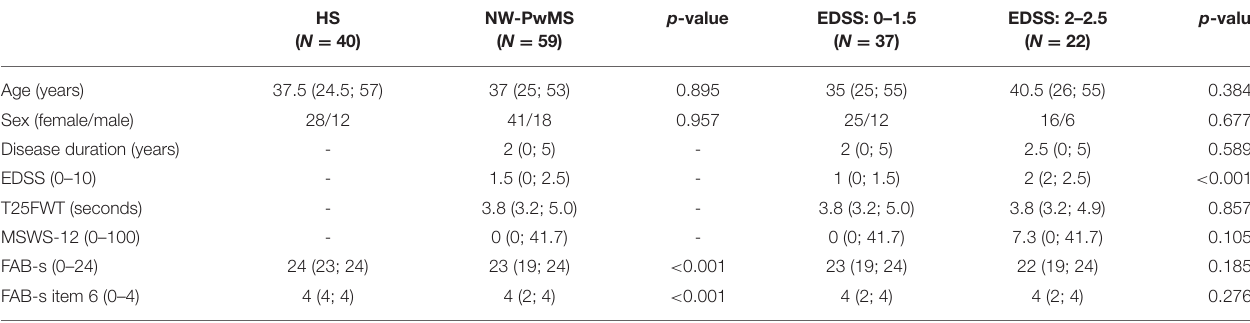
TABLE 2 | Demographic and clinical characteristics of healthy subjects and normal-walking people with MS.